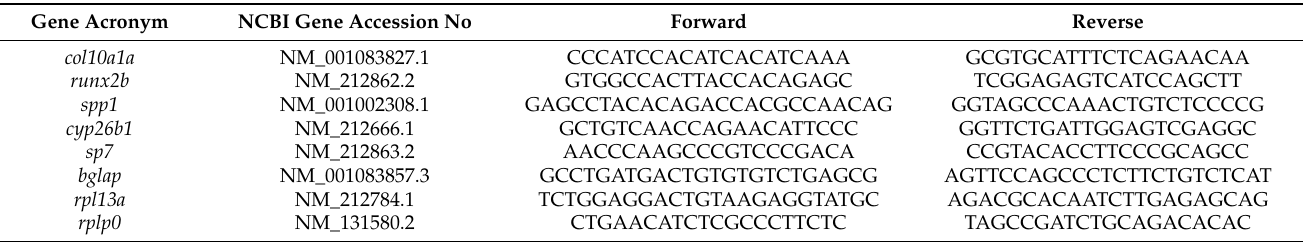
Table 1. List of primers used for